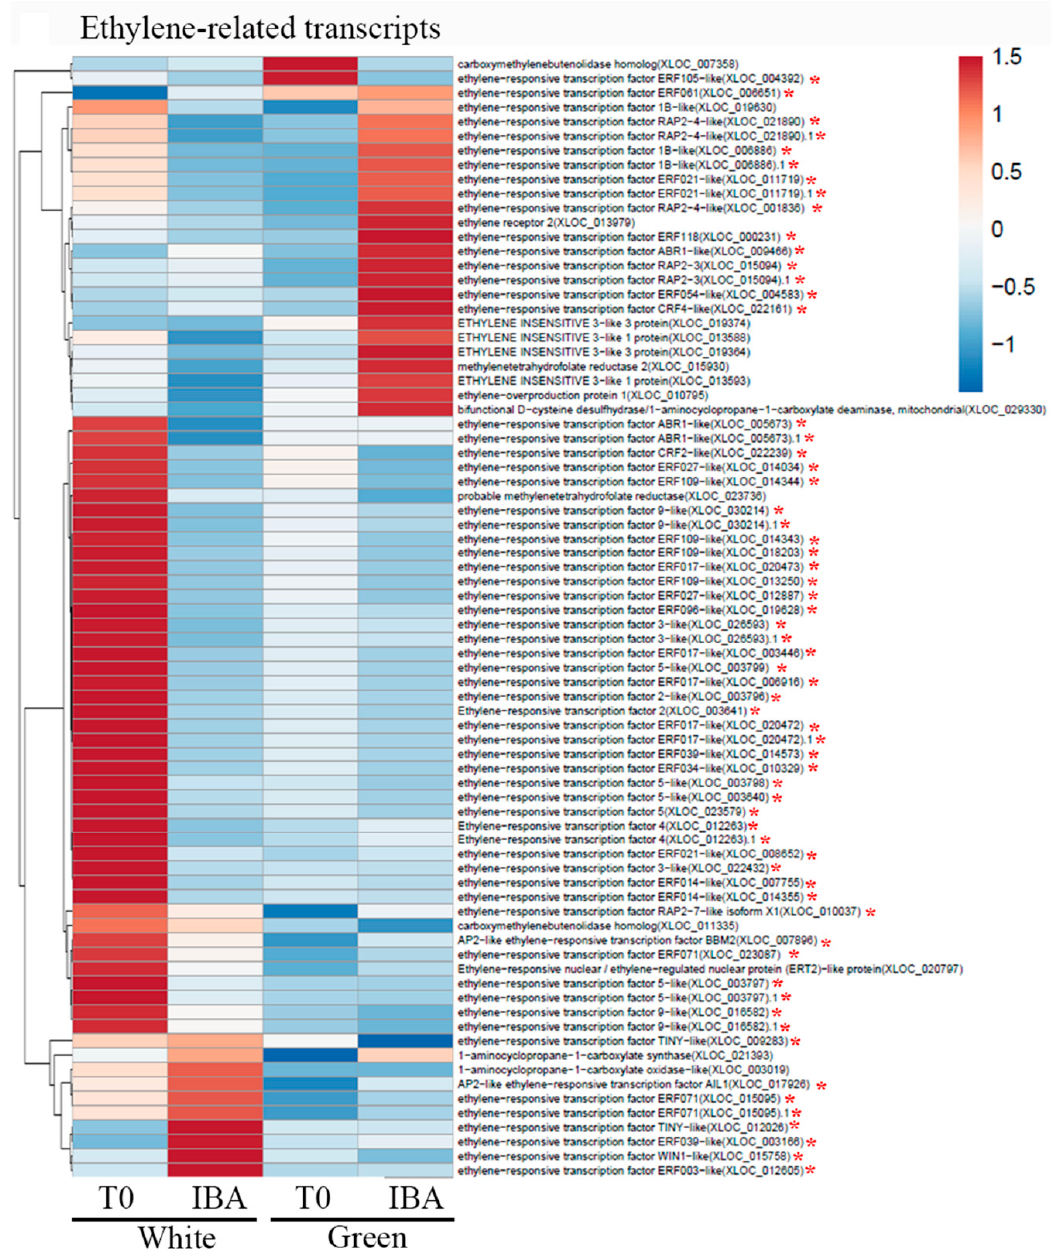
Figure 6. Heatmap analysis. Differentially expressed genes were scored for transcripts related to ethylene biosynthesis. Red asterisks show ethylene responsive transcription factors.